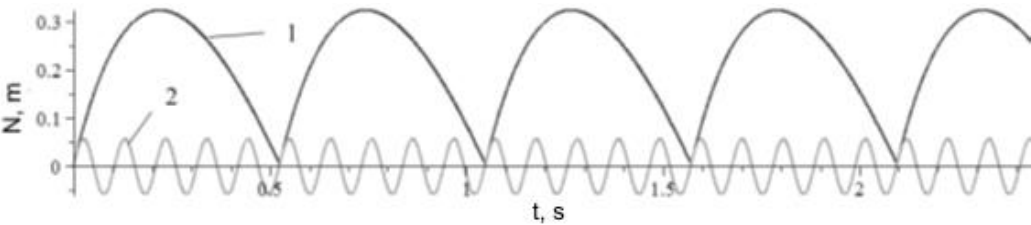
Fig. 4. A particle trajectory at the implementation of the mode with multiple